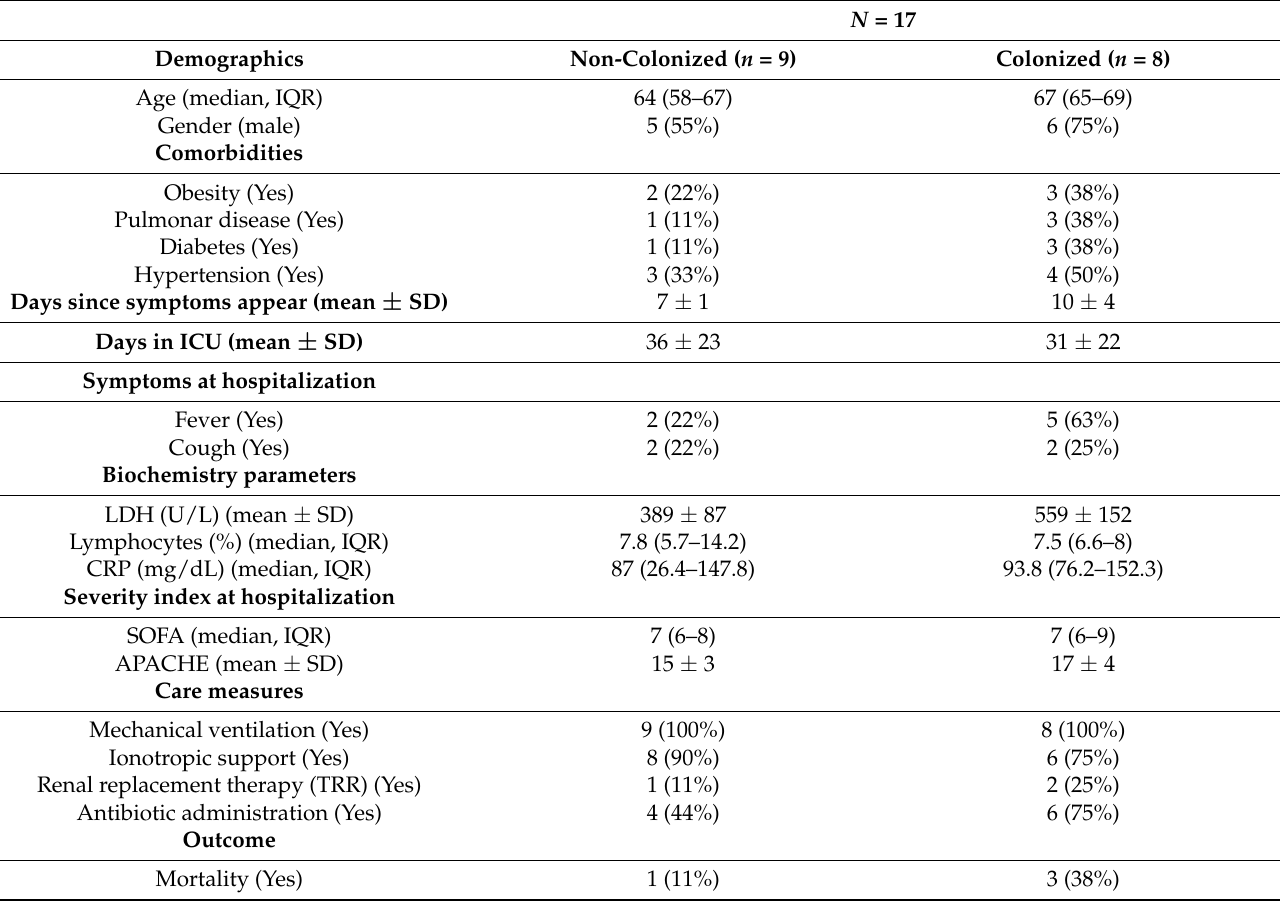
Table 1. Clinical data for recruited patients.